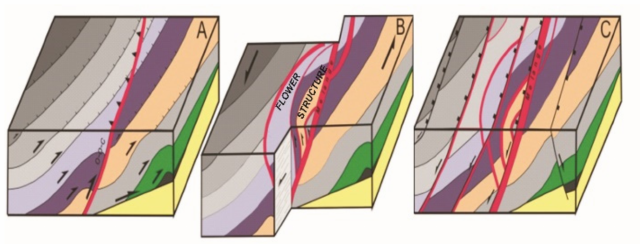
Figure 2. Explanation of formation of tectonic m é lange zone. ( A ) Primary stage with out-of-sequence thrust; ( B ) Re-activation and formation of flower structure; ( C ) Final stage—tectonic m é lange zone (based on